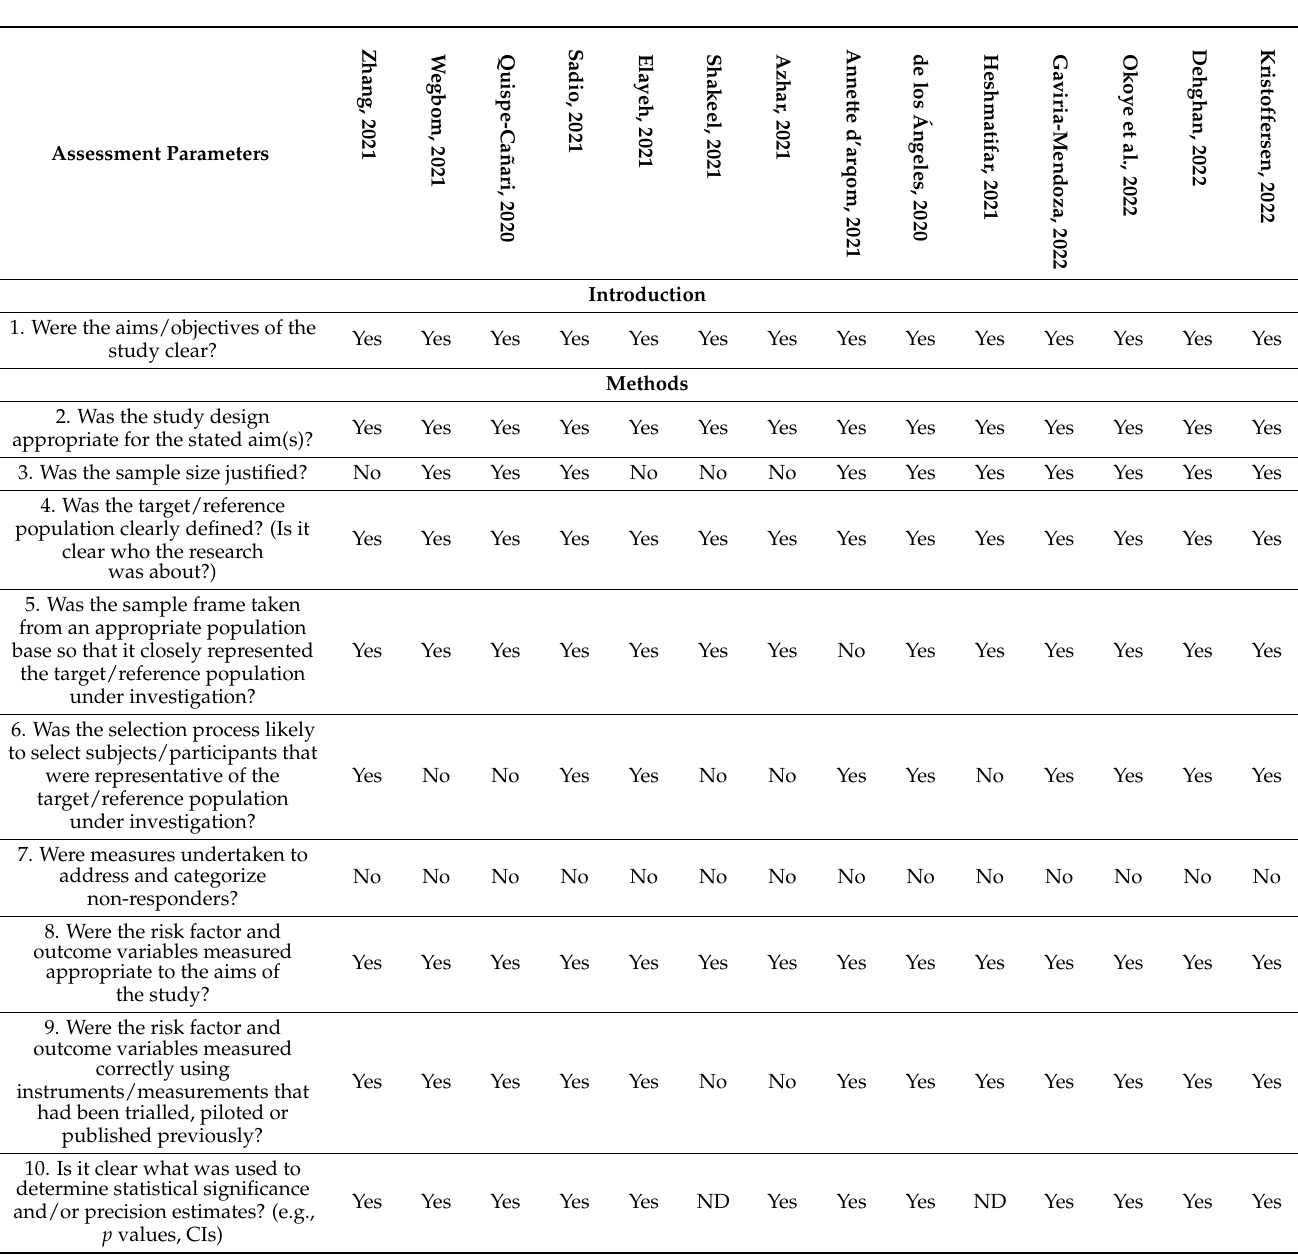
Table 1. Assessment of the risk of bias in the reviewed